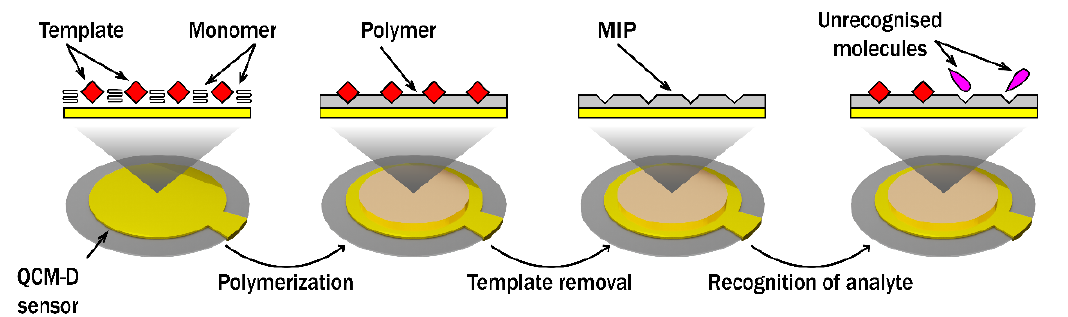
Figure 4. Preparation and working principle of molecularly imprinted polymer (MIP) on a QCM-D sensor disk.